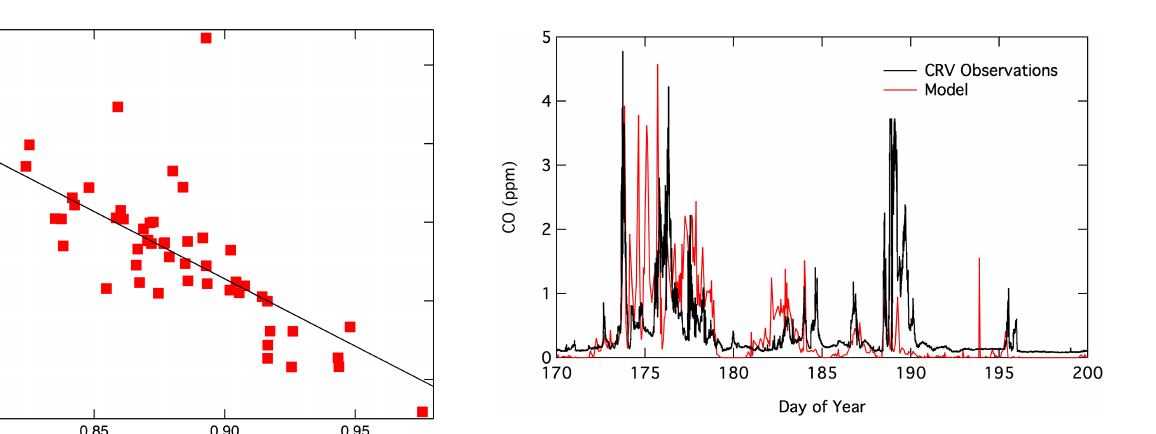
Figure 8. CRV observations of CO (black) compared with the mod- eled CO anomaly from fires (red) derived from the PWRF-STILT atmospheric model driven by AKFED fire emissions. The trace gas observations and model predictions are shown at a 1h temporal res- olution.